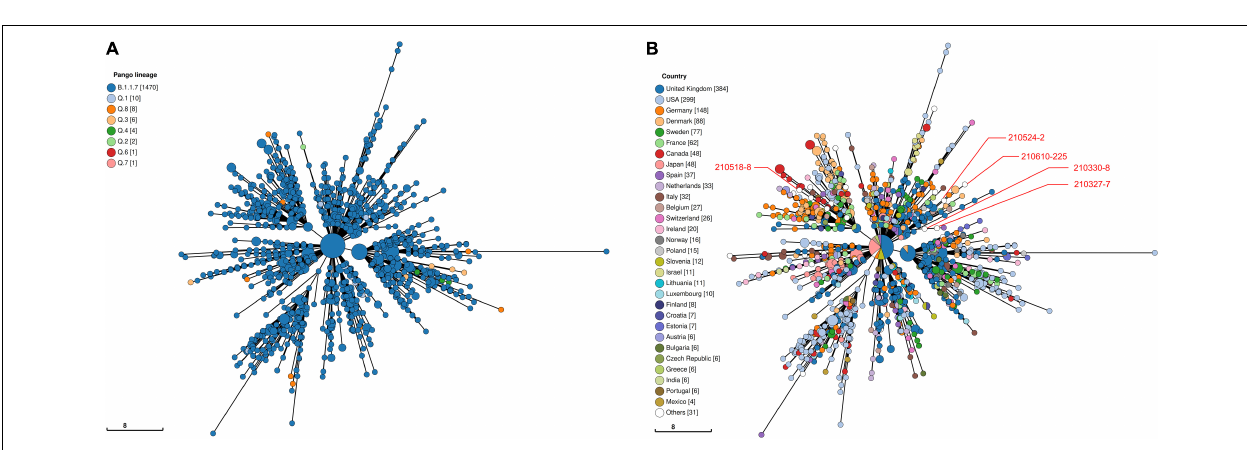
FIGURE 5 | Haplotype network analysis using genome-wide single-nucleotide variations of VOC Alpha in the world. The VOC Alpha were compared with GISAID-available SARS-CoV-2 genomes ( n = 1,505, updated on October 09, 2021). (A) The Pango lineages of VOC Alpha. The lineages are marked with different colors. (B) The countries distribution of VOC Alpha. The colors represent different countries. Scale lengths represent the genetic